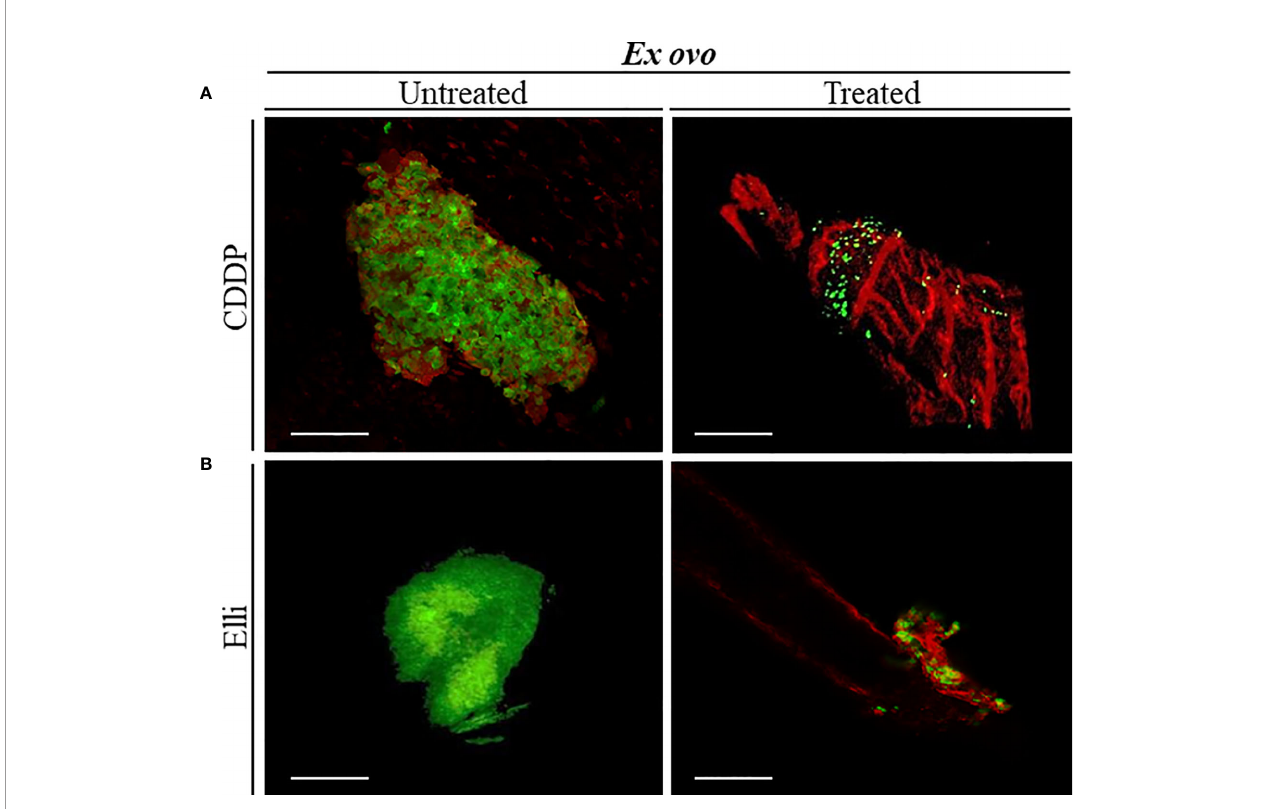
FIGURE 3 | Examination the inhibitory effects of (A) cisplatin (CDDP) and (B) ellipticine (Elli) on neuroblastoma (Nbl) tumor development by ex ovo chick chorioallantoic membrane (CAM) assay. Confocal laser scanning microscopy (CLSM) micrographs of UKF-NB-4 tumor treated with CDDP and Elli for 24 h (each photo corresponds to an independent tumor). Viable Nbl cells are green (labeled with CellTracker), and angiogenic vessels are red [labeled with rhodamine Lens culinaris agglutinin (LCA)]. Scale bar, 200 m